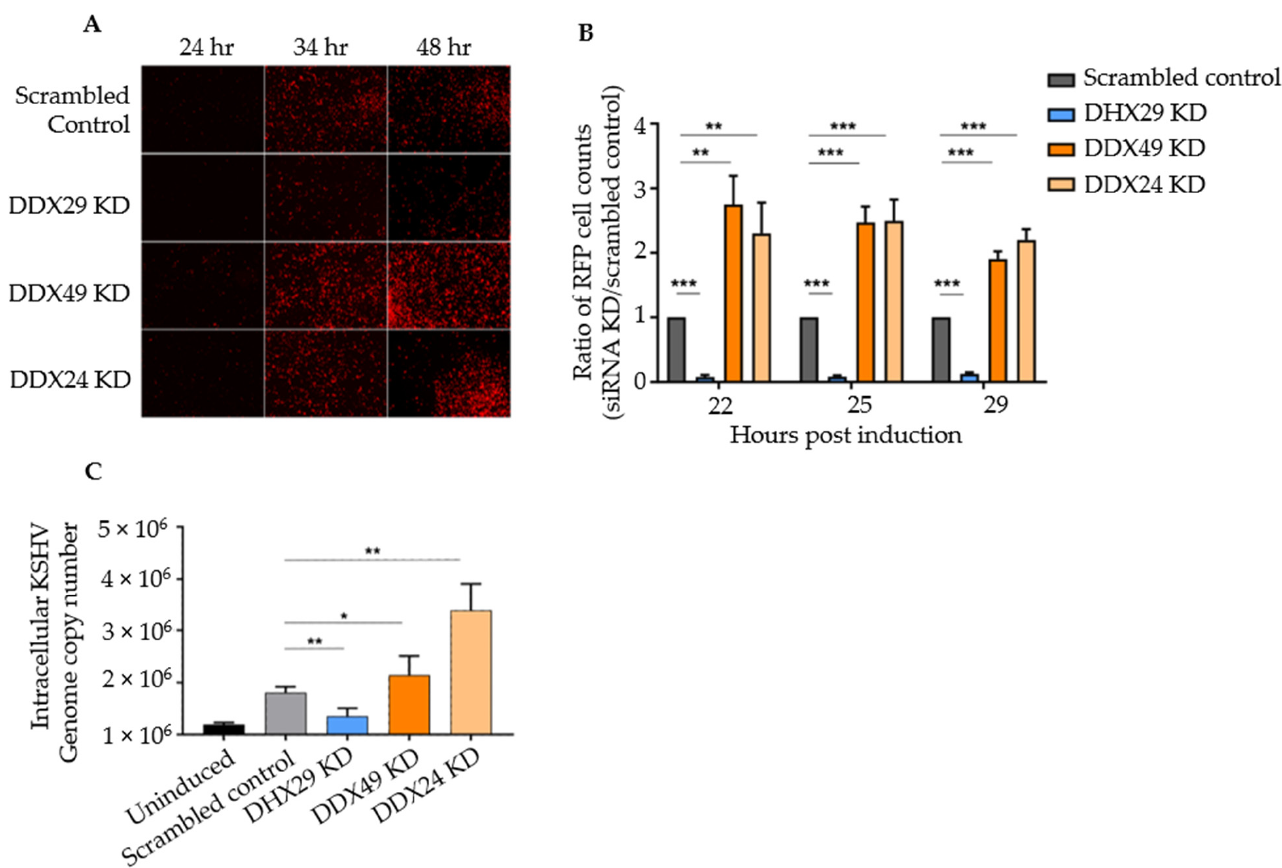
Figure 1. siRNA knockdown screen of selected DExD/H box helicases in Vero cells latently infected with rKSHV.219. ( A ) Fluorescence microscopy results of knockdown with scrambled siRNA control and with siRNAs against DHX29, DDX49, and DDX24 at 24, 34, and 48 h post-induction. All transient KD Vero cells looked healthy 28 h after siRNA transfection and prior to chemical induction, with negligible spontaneous background reactivation. ( B ) Counts of RFP + cells for selected knockdowns with three random fields of vision per biological replicate. ( C ) Intracellular DNA copy number as determined by quantitative PCR under the same knockdown conditions. Values are expressed as a ratio normalized to the scrambled control (n = 4 independent trials, *** p < 0.001, ** p < 0.01, * p < 0.1). To confirm that RFP expression truly represented lytic DNA replication, intracellular KSHV genomic DNA was measured by qPCR with primers that amplify the C-terminus of ORF73 encoding LANA. Primer sequences are listed in Table S3. qPCR results estimate the viral copy number at 48 h post-induction representing active KSHV replication.